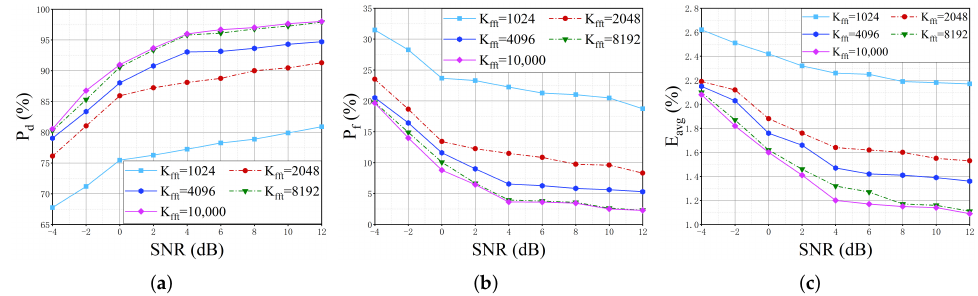
Figure 9. Performance variations with different numbers of FFT points. ( a ) detection probability; ( b ) false alarm probability; ( c ) mean absolute error of parameter